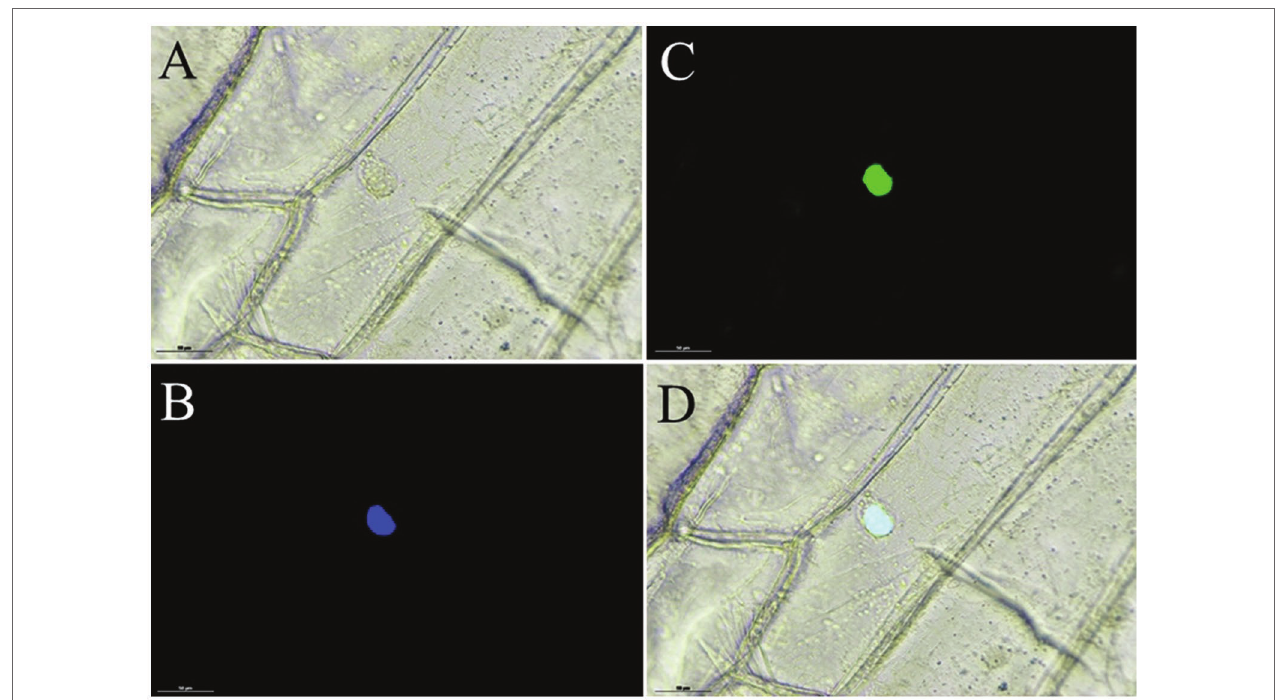
FIGURE 2 | Subcellular localization of EgMADS16 protein in onion epidermal cells. (A) Bright light. (B) DAPI. (C) EgMADS-GFP fluorescence. (D) Merged image. Scale bar, 50 μ